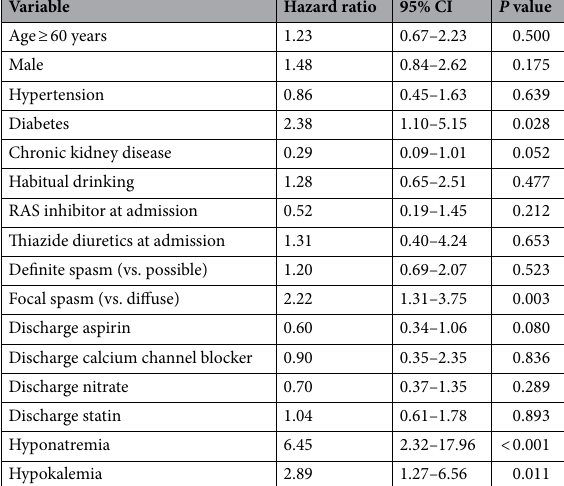
Variable Hazard ratio 95%